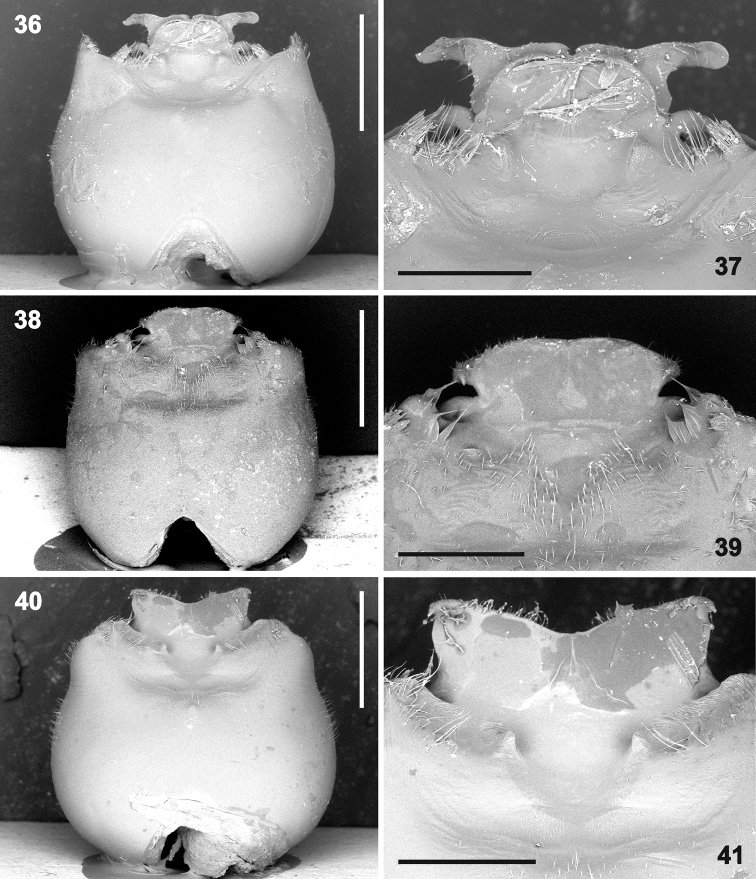
Genital capsule (36, 38, 40 magnification 32×) and detail of hypandrium (37, 39, 41 80×) in ventral view. 36–37Rh.henryi sp. n., holotype, French Guiana, Camp Caimans 38–39Rh.meinanderi Becker & Grazia-Vieira, 1971, Ecuador, Yasui NP 40–41Rh.wheeleri sp. n., holotype, Guyana. Scale bars: 1 mm (36, 38, 40); 0.5 mm (37, 39, 41). (micrographs P. Kment)